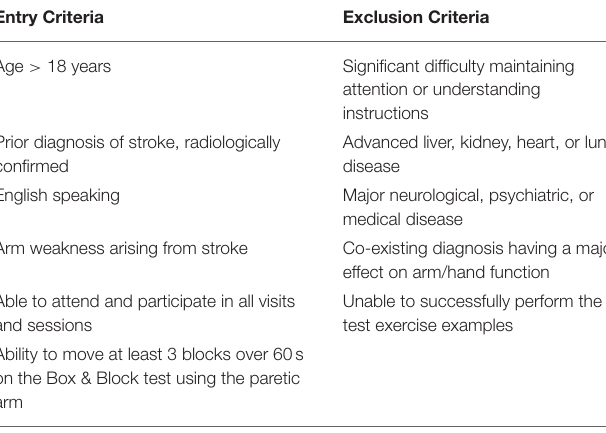
TABLE 1 | Entry and exclusion